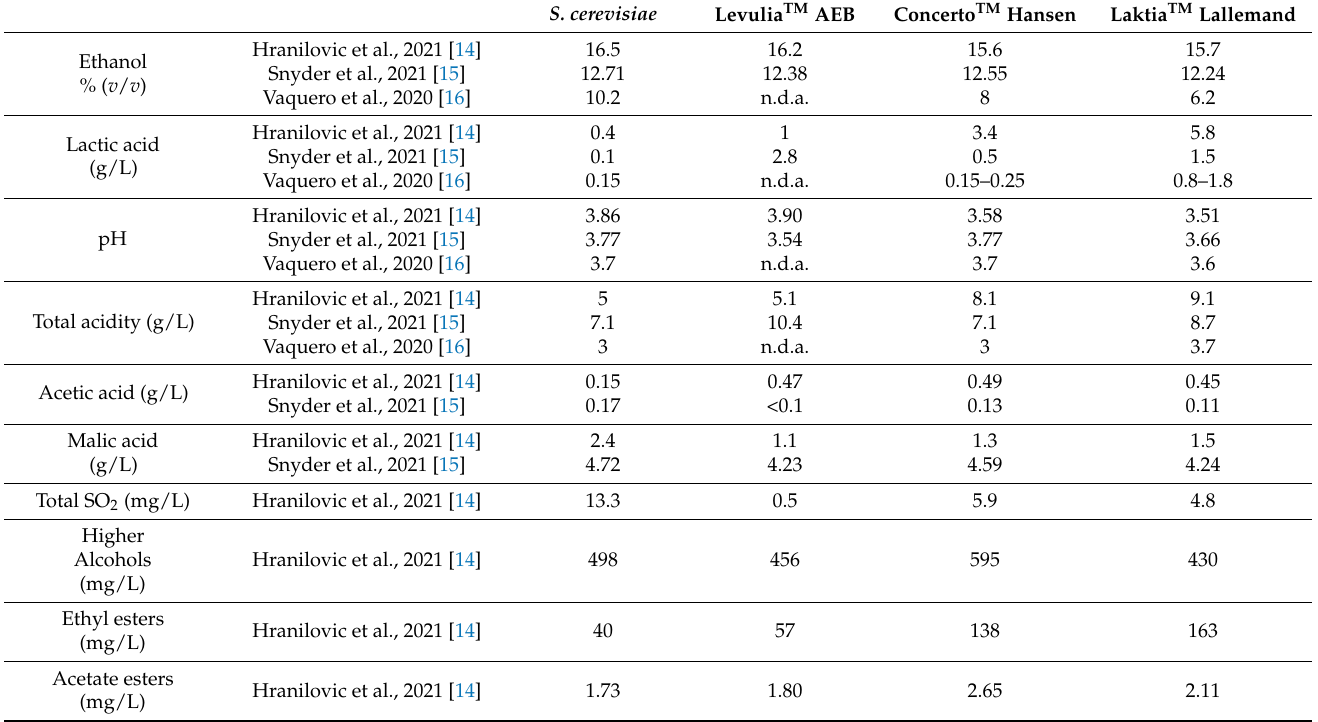
Table 2. Summary of studies that have compared different commercial L. thermotolerans strains in wine fermentation. S.